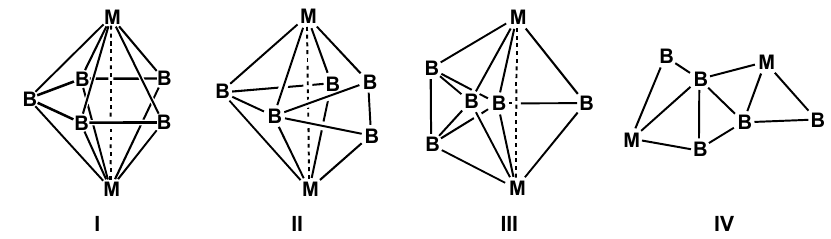
Figure 1. Different architectures reported for M 2 B 5 metallaborane clusters. Figure 1. Di ff erent architectures reported for M 2 B 5 metallaborane